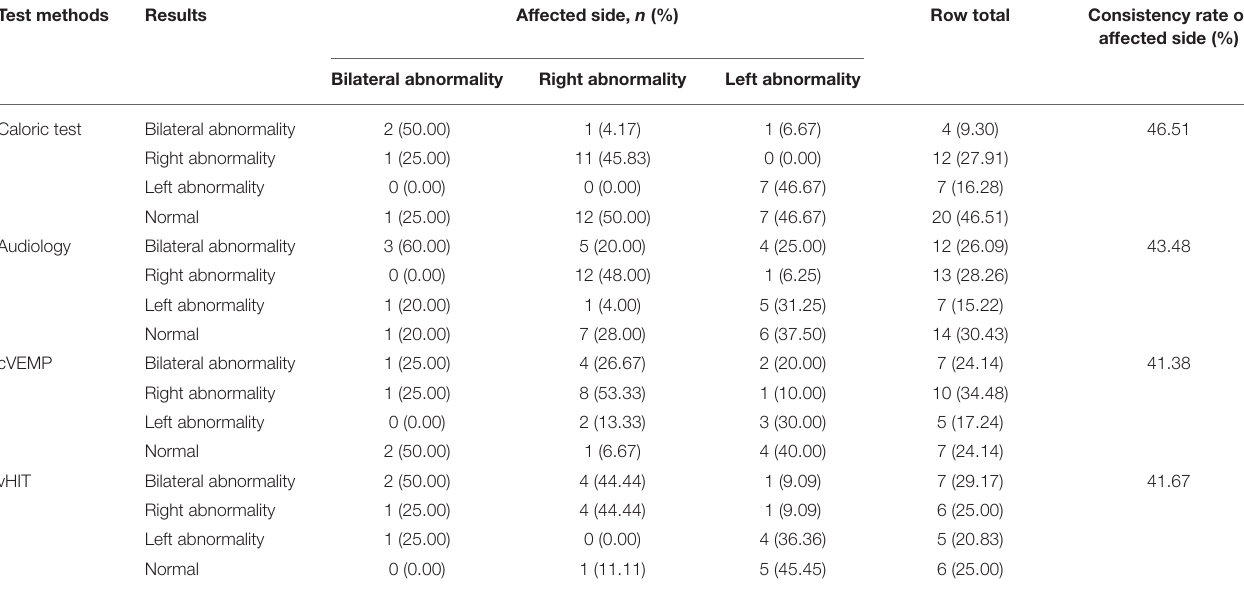
TABLE 3 | Cross table of the test results of caloric test, audiology, cVEMP, vHIT, and the condition of the affected side. Test